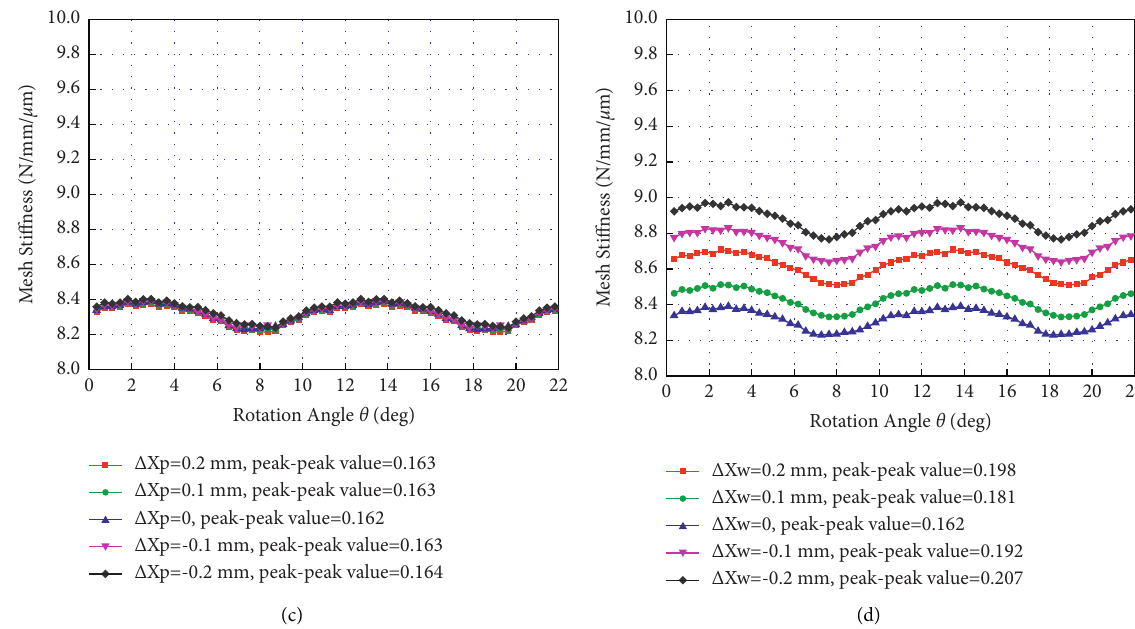
Figure 12: Time-varying mesh stiffness. (a) Shaft angle deviation. (b) Offset deviation. (c) Pinion mounting distance deviation. (d) Wheel mounting distance